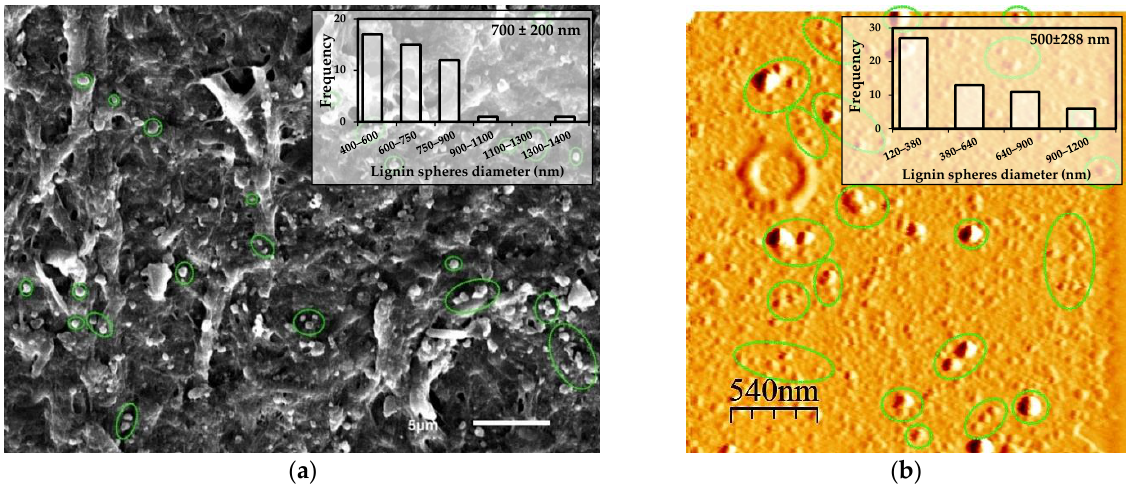
Figure 6. Lignin particles from TMP-NF. ( a ) SEM micrograph; ( b ) AFM image. Note: The green circles in the figure indicate the lignin particles.